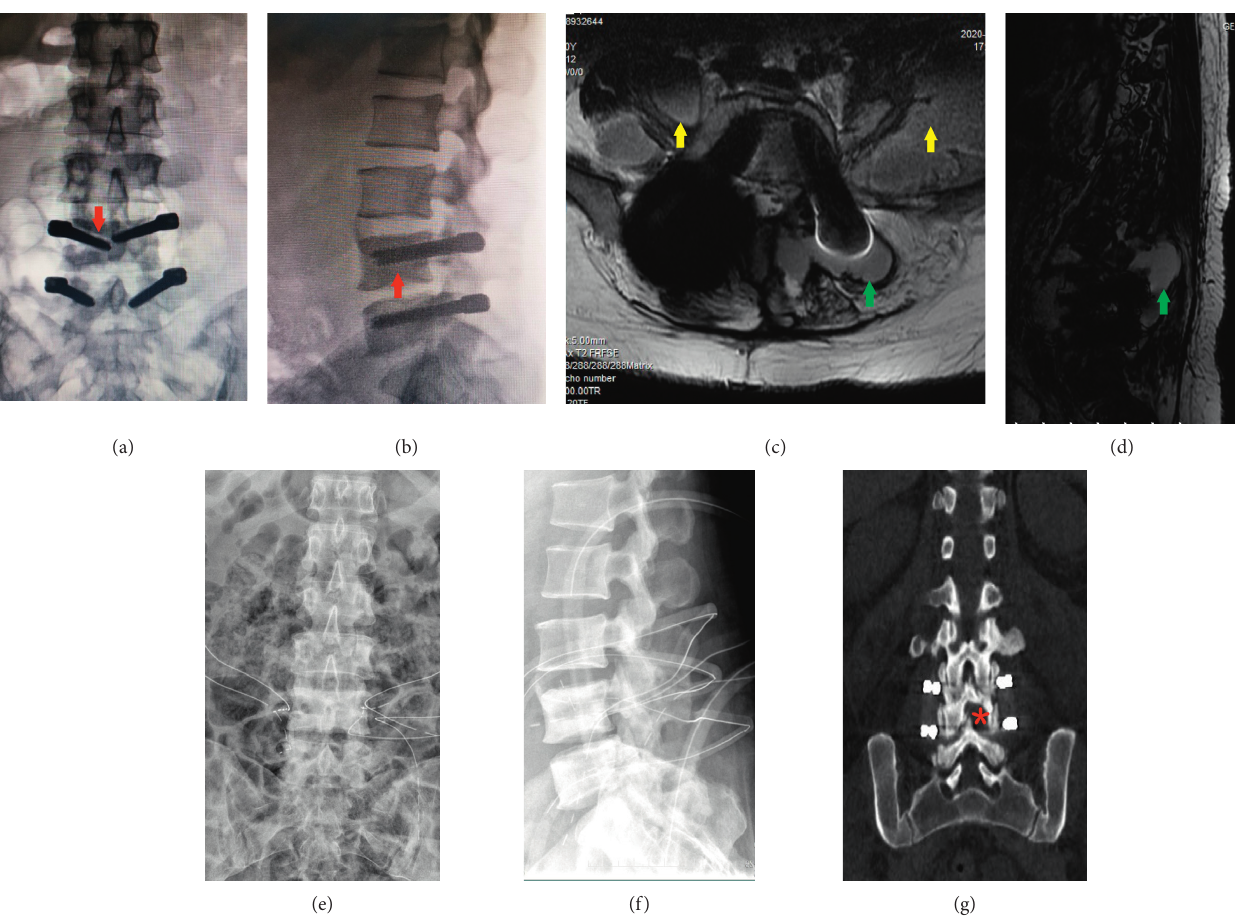
Figure 1: (a, b) Three years after L4-5 Dynesys dynamic internal fixation, anteroposterior and lateral X-view: the red arrow indicates bone resorption and loosening of the pedicle screw (halo sign). (c, d) Lumbar MRI: the green arrows indicate empyema around pedicle screws and spacers, and the yellow arrows indicate bilateral psoas muscle abscesses. (e, f) Placing drainage tubes after removal of the implant. (g) Opening a window between the lamina, retaining the lateral 1/2 of the inferior articular process in